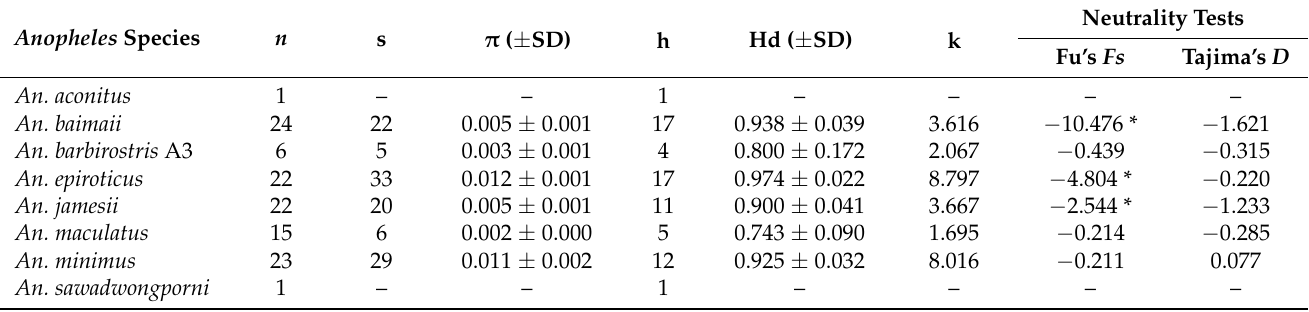
Table 4. Genetic diversity indices and neutrality tests of Anopheles species in